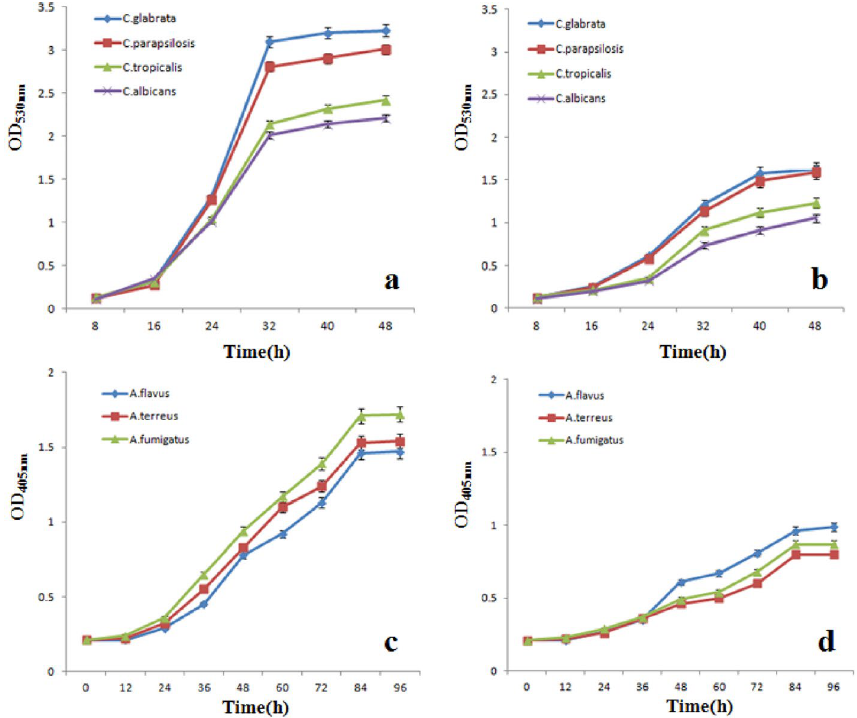
Figure 9. Fungal growth kinetics of Candida and Aspergillus in the absence of AgNPs ( a , c ) and the presence of AgNPs ( b , d ) ( p < 0.05).